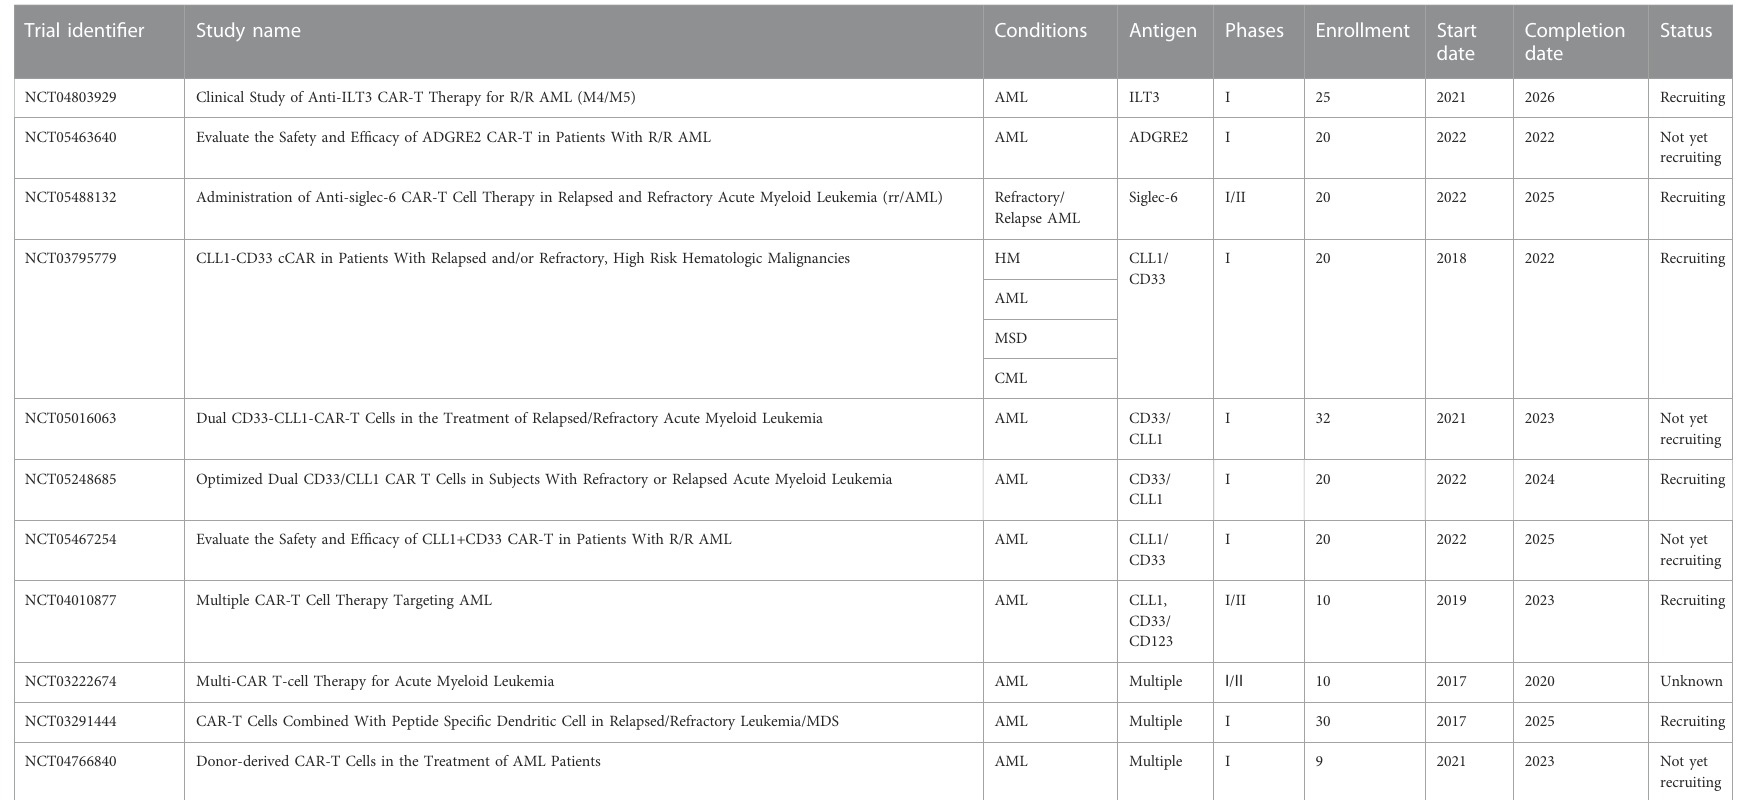
TABLE 3 ( Continued ) Current clinical trials using CAR T-cell for immunotherapy of